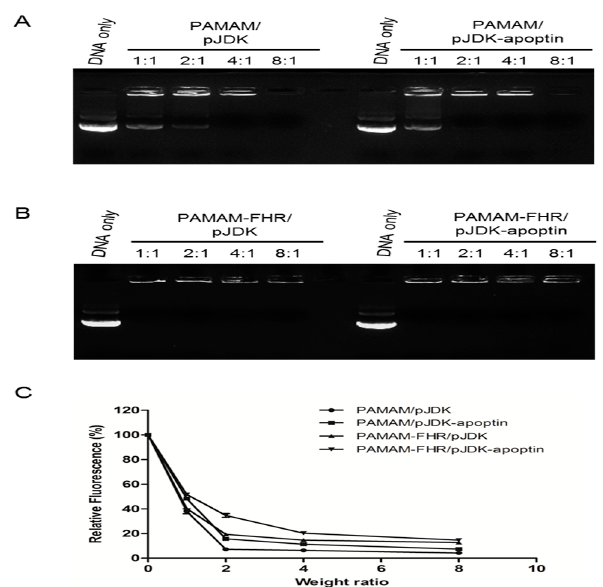
Figure 1. Gel electrophoresis and PicoGreen assays of pJDK-apoptin complexes. ( A ) and ( B ) each polymer/DNA complex at different weight ratios (0, 1, 2, 4, and 8). Each lane is the weight ratio of polymer/DNA. The DNA concentration was 0.5 µg/µL. ( C ) Complexes were prepared under the same conditions as those used for the gel retardation. The intensity was normalized to 100% in pJDK and pJDK-apoptin plasmid DNA. Results are shown as the mean ± standard deviation, n = 3.